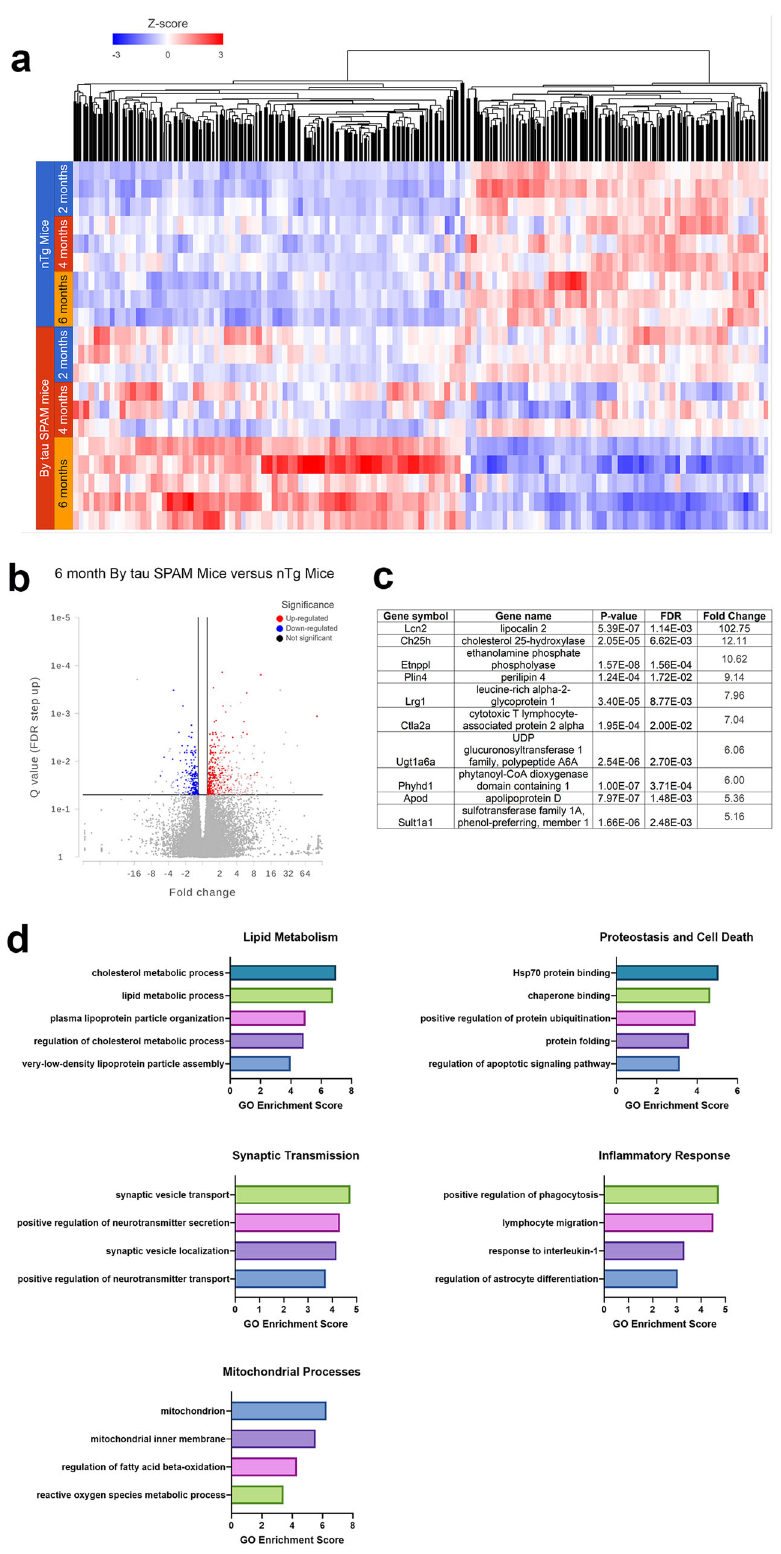
Fig. 8 Major transcriptomic changes and pathway alterations are found primarily at 6 months with high tau inclusion density. a Heatmap shows hierarchical clustering of major gene expression changes between nTg and tau SPAM mice at 2, 4, and 6 months. b Volcano plot shows 473 differentially expressed genes between 6-month-old tau SPAM and nTg mice. c Top-ten signi fi cantly altered genes in tau SPAM mice based on fold change are listed in a table. d Major gene ontology enrichment and signi fi cant pathways are altered in tau SPAM mice, including lipid metabolism, proteostasis and cell death, synaptic transmission, in fl ammatory response, and mitochondrial